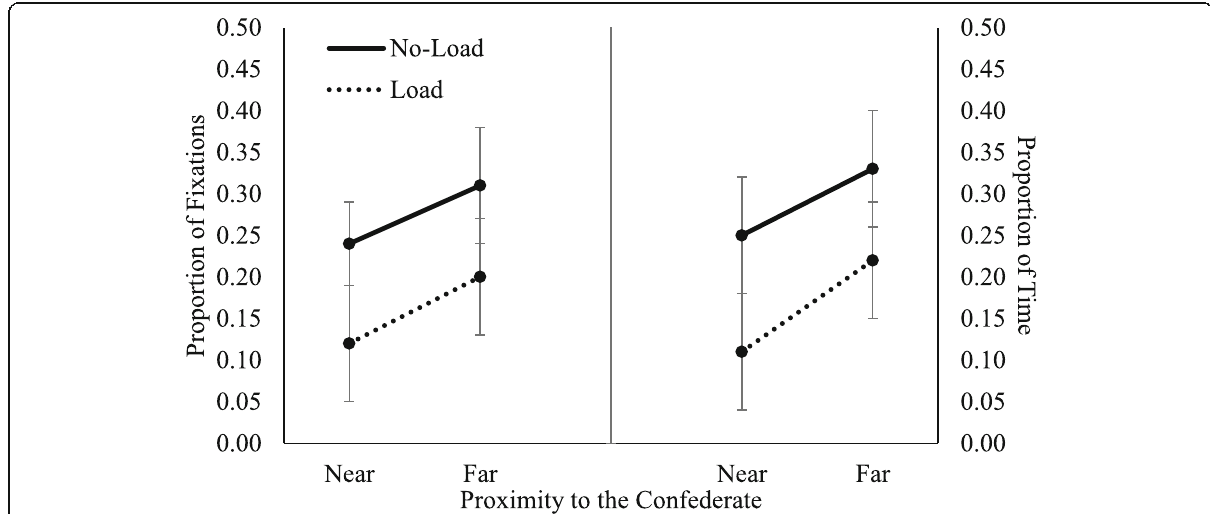
Fig. 2 The mean proportion of fixations (left panel) and time spent on the confederate (right panel) when the confederate was in view for Condition (no-load, load) and Proximity (near, far) in Experiment 1. Bars show 95% confidence intervals